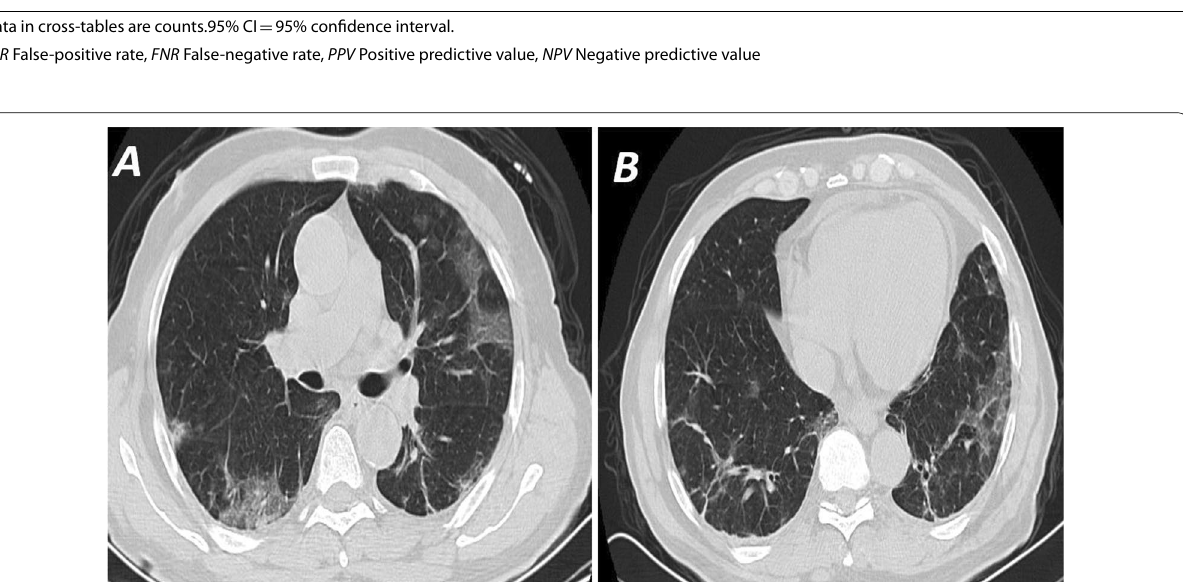
Data in cross-tables are counts.95% CI